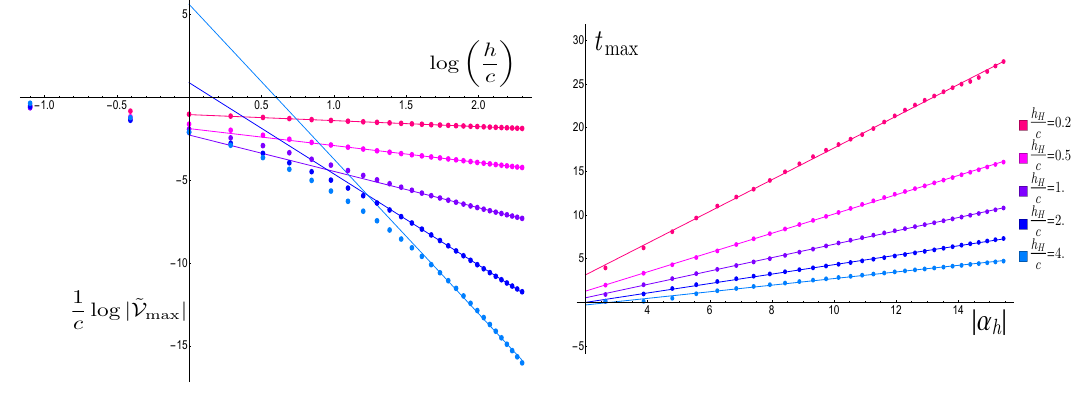
~ Figure 11 . These plots show a host of data demonstrating that and t max have simple j V max j 24 h dependence on h when h & h H (recall (cid:11) h 1 ) for a large variety of di(cid:11)erent choices c c (cid:17) (cid:0) of h H . For all of these plots we choose c = 10, but we have found that the results are robustly q c -independent. These plots use h L = c , but h L dependence is mild, as seen in (cid:12)gure 12. 30